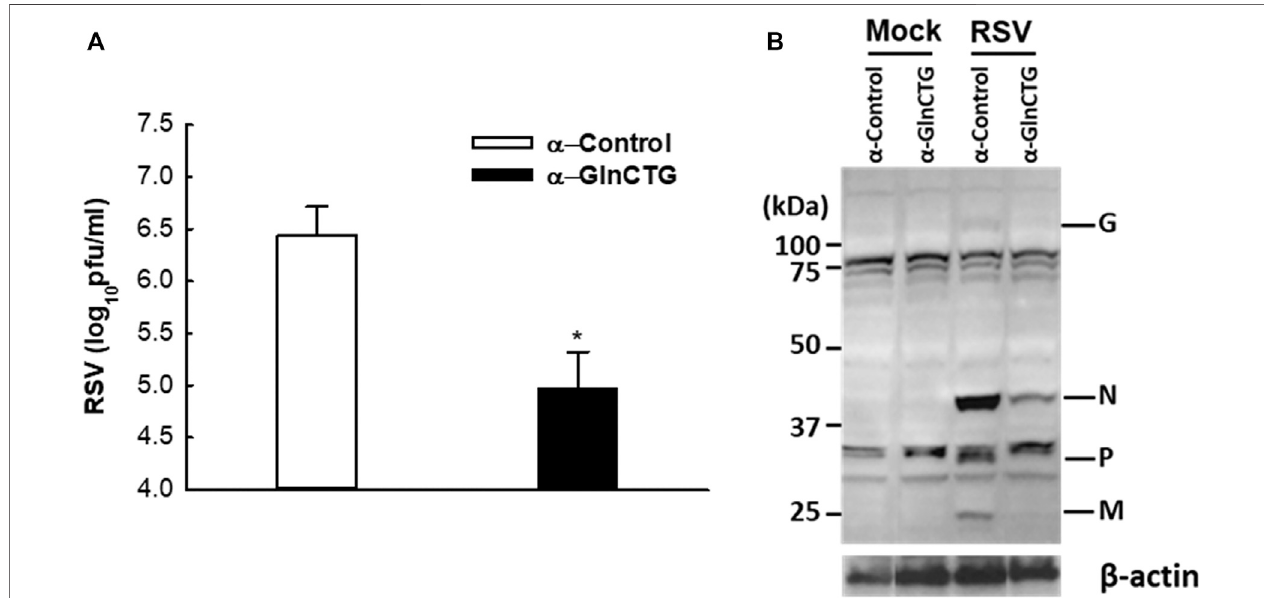
FIGURE 1 | The effect of tRF5-GlnCTG on RSV replication. A549 cells in duplicate were transfected with 120 nmol/l of an antisense oligo against tRF5-GlnCTG ( α -GlnCTG)orscrambled oligo( α -Control)usingLipofectamine2000.At2 hpost-transfection,thecellsweremock-infected orinfectedwithRSVatanMOIof1for15 h. (A) Total viruses were harvested and infectious particles were quanti fi ed by immunostaining using an anti-RSV antibody. (B) Total proteins were prepared, and the expression of viral proteins was measured by Western blot using an anti-RSV antibody. RSV proteins are indicated on the right and molecular size markers are on the left. β -actin was used as a control for equal loading of the samples. The sequence of α -GlnCTG and α -Control is shown in Supplementary Table S1 . Data are representative of three independent experiments. * P < 0.05, relative to the white bar.